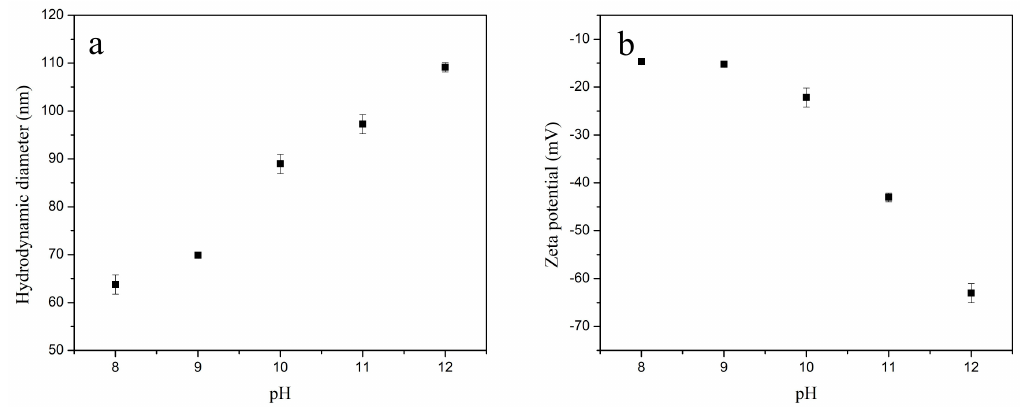
Figure 6. Hydrodynamic diameter ( a ) and zeta potential ( b ) of SiO 2 - g -PAA nanoparticle as a function of pH, at 25 °C. The error bars correspond to standard deviations from three measurements.